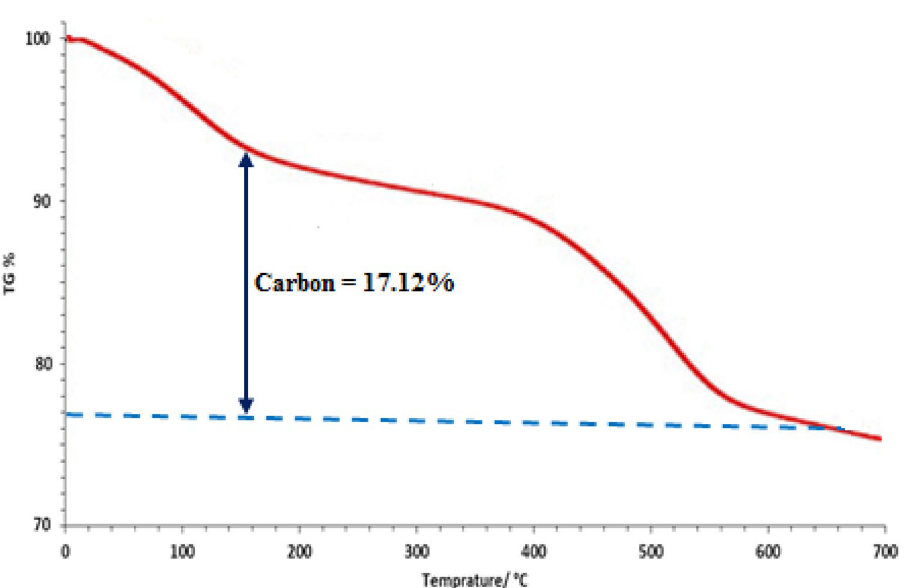
Figure 9. TGA profile of CuO